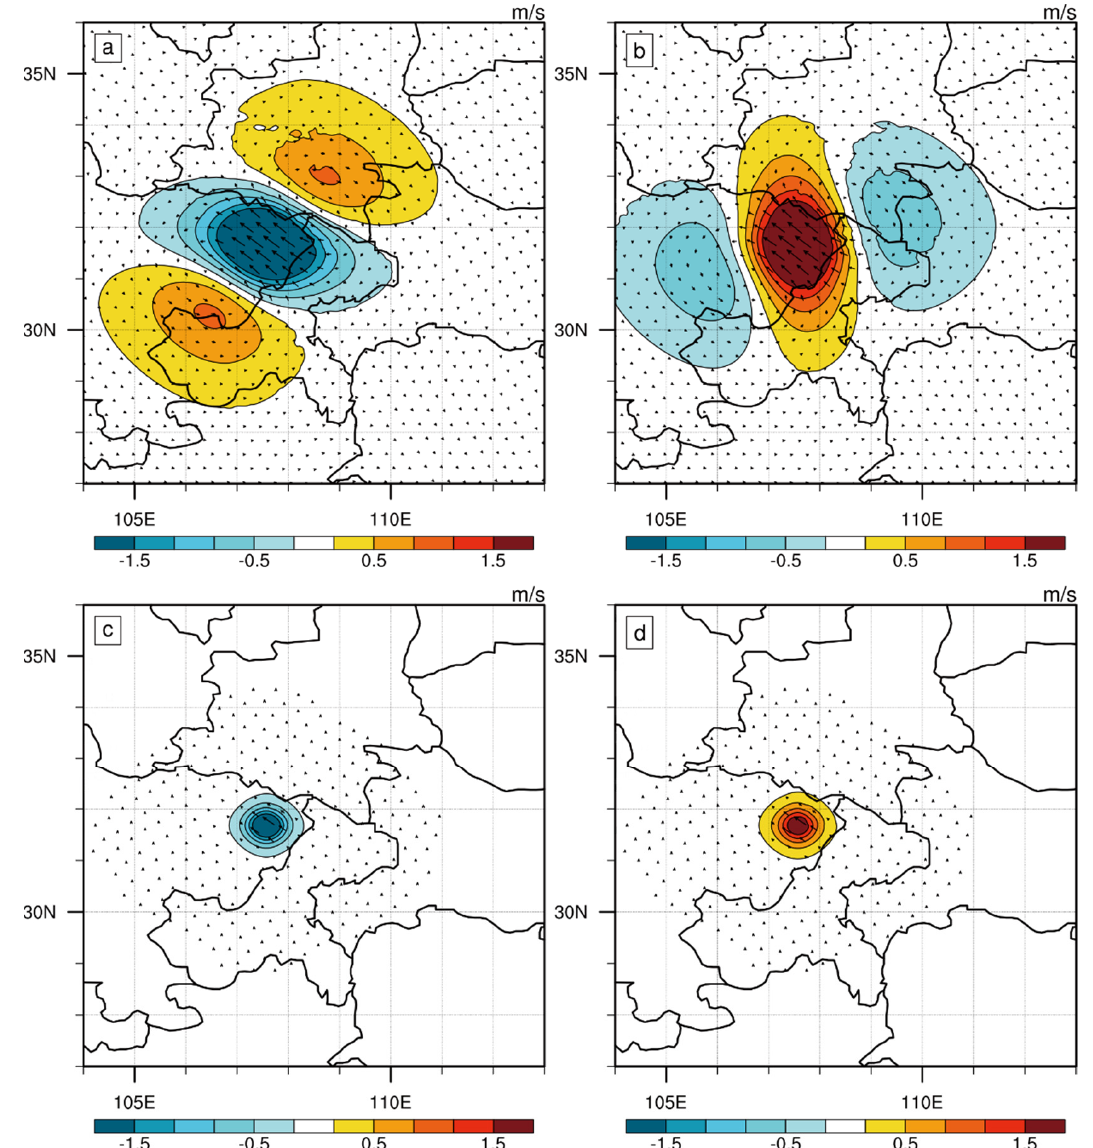
Figure 4. The increments of ( a , c ) U and ( b , d ) V wind (shaded; units: m s − 1 ) and wind vector at 700 hPa from single observation experiments using ( a , b ) the ψ−χ control variable, and ( c , d ) U − V control variable.